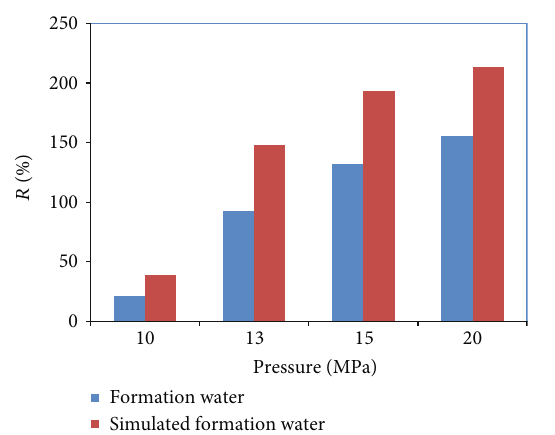
fl ooding. Figure 8: Porosity changing with pressure after CO 2